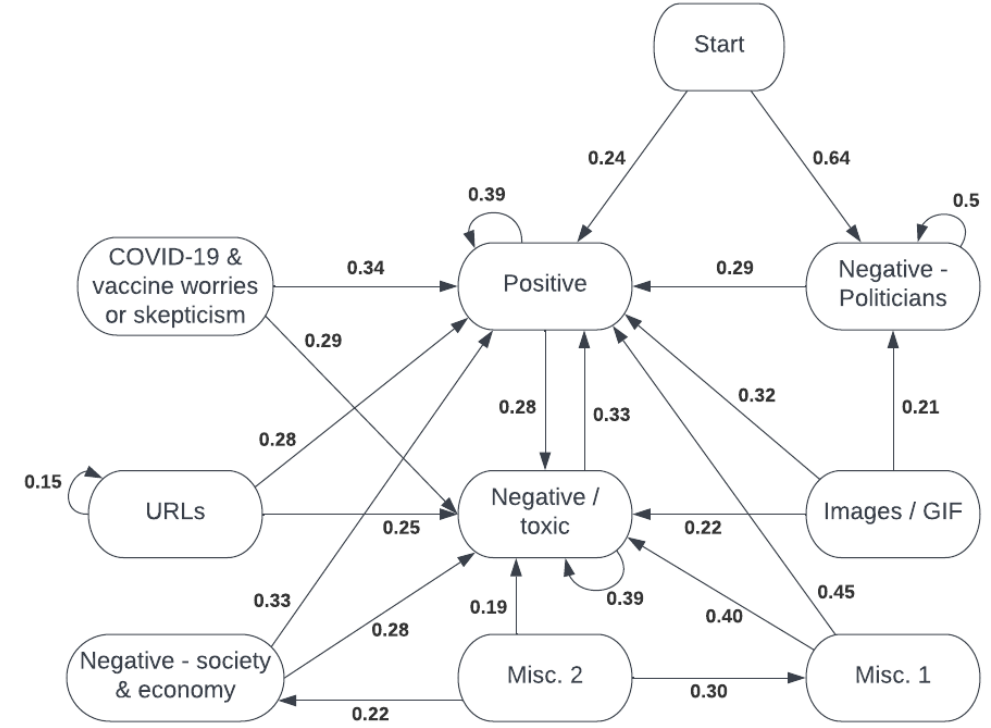
Figure 2. Our HMM represented as a